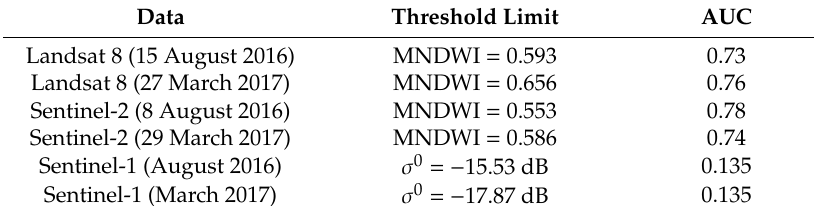
Table 3. Threshold limits obtained from the ROC curve analysis.